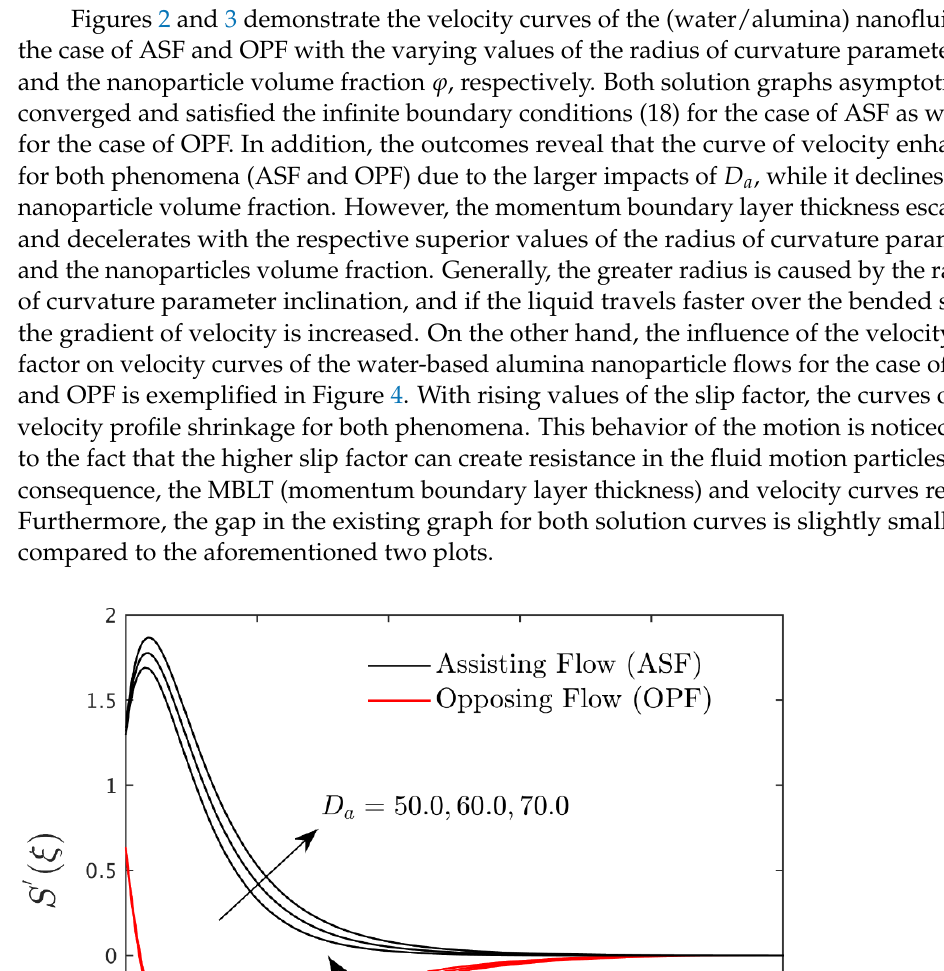
Figure 3. Velocity profile for the case of ASF and OPF due to variations in the values of  .